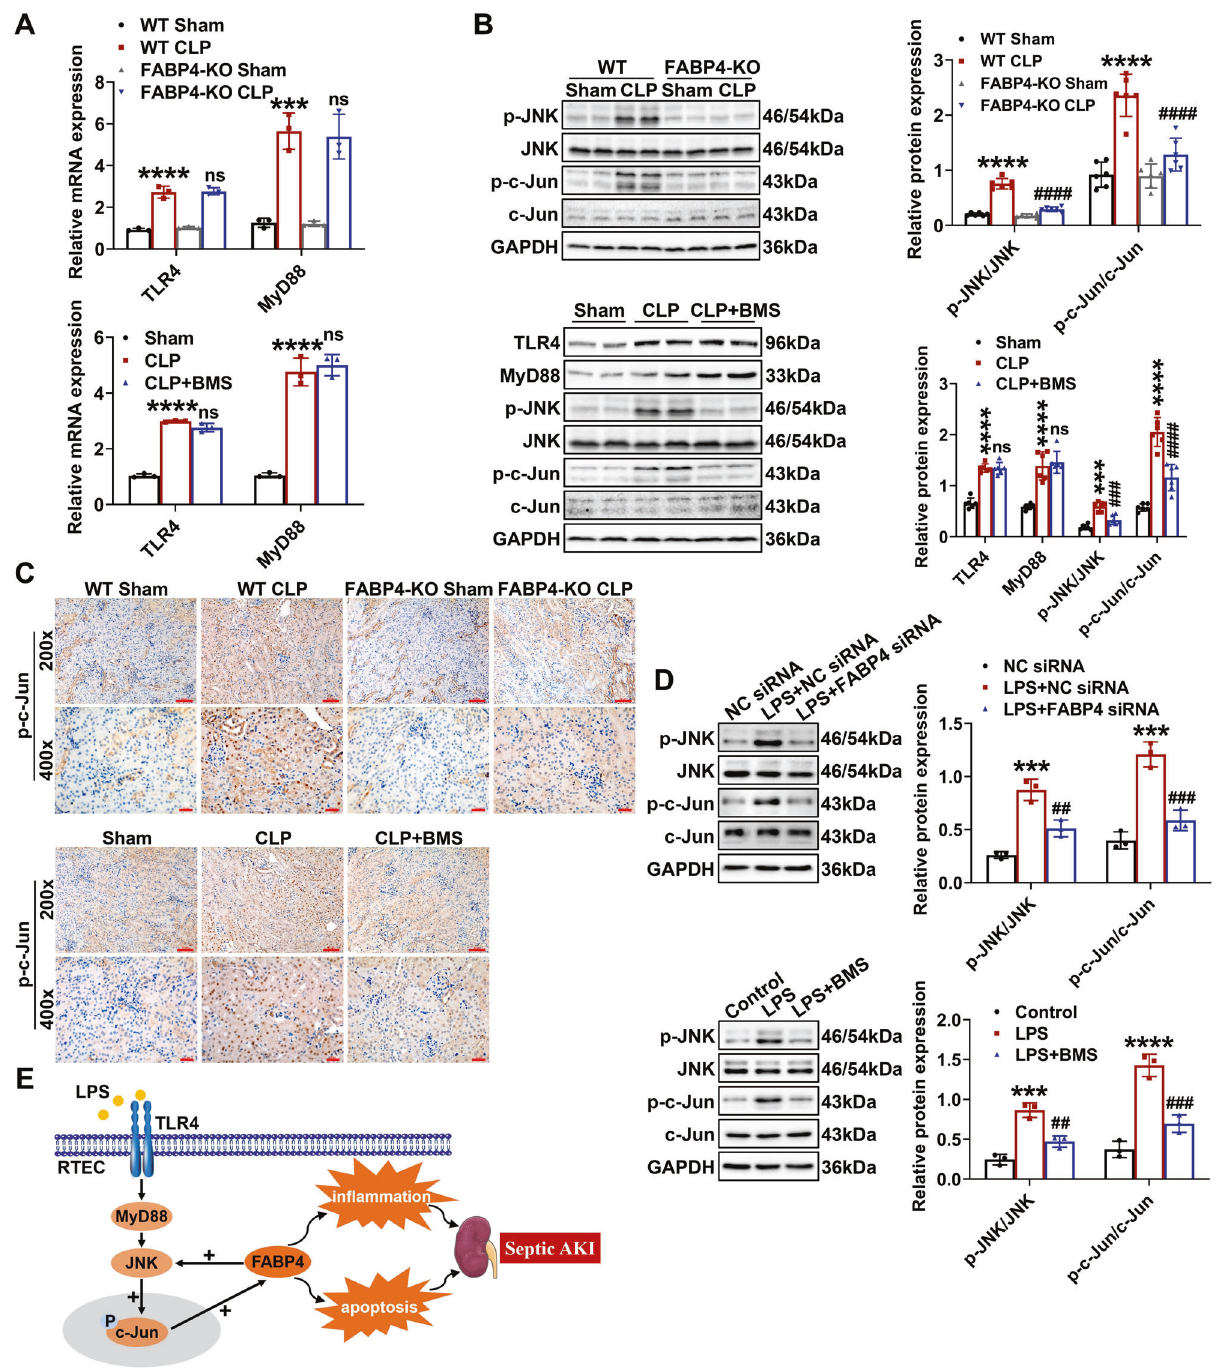
Fig. 8 Tubular FABP4 formed a positive feedback loop with c-Jun in septic AKI. C57BL/6J, FABP4 inhibitor BMS309403 (BMS)-treated C57BL/ 6J, FABP4 KO, and WT mice (male, 8 – 10 weeks old) were subjected to CLP or sham surgery and killed 16 h later. TCMK-1 cells were transfected with negative control (NC) siRNA or FABP4 siRNA for 24 h and then treated with 100 μ g/ml LPS for another 24 h, or either untreated or pretreated with 10 μ M BMS for 30 min before 24 h of 100 μ g/ml LPS stimulation. A Renal mRNA levels of TLR4 and MyD88 measured by quantitative real-time PCR ( n = 3). B Renal protein levels of TLR4, MyD88, p-JNK, JNK, p-c-Jun, and c-Jun examined by western blotting and quanti fi ed by densitometry ( n = 6). C Immunochemistry staining of p-c-Jun in kidney tissue sections (×200, scale bar = 50 μ m; ×400, scale bar = 20 μ m). Data are shown as mean ± SD; *** P < 0.001, **** P < 0.0001 for WT CLP versus WT Sham, or for CLP versus Sham; ns = no signi fi cance, ### P < 0.001, #### P < 0.0001 for FABP4-KO CLP versus WT CLP, or for CLP + BMS versus CLP. D Western blotting and densitometry quanti fi cation of p-JNK, JNK, p-c-Jun, and c-Jun in TCMK-1 cells. Data are shown as mean ± SD ( n = 3); *** P < 0.001, **** P < 0.0001 for LPS + NC siRNA versus NC siRNA, or for LPS versus Control; ## P < 0.01, ### P < 0.001 for LPS + FABP siRNA versus LPS + NC siRNA, or for LPS + BMS versus LPS. E Schematic illustration of the role and regulation of tubular FABP4 in the pathogenesis of septic AKI.